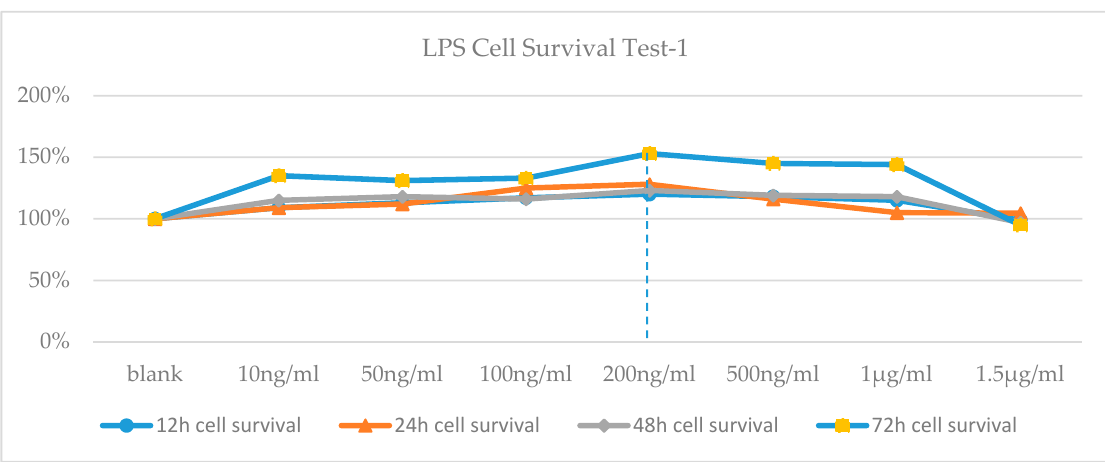
Figure 1. Cell Viability-time chart of LPS-applied